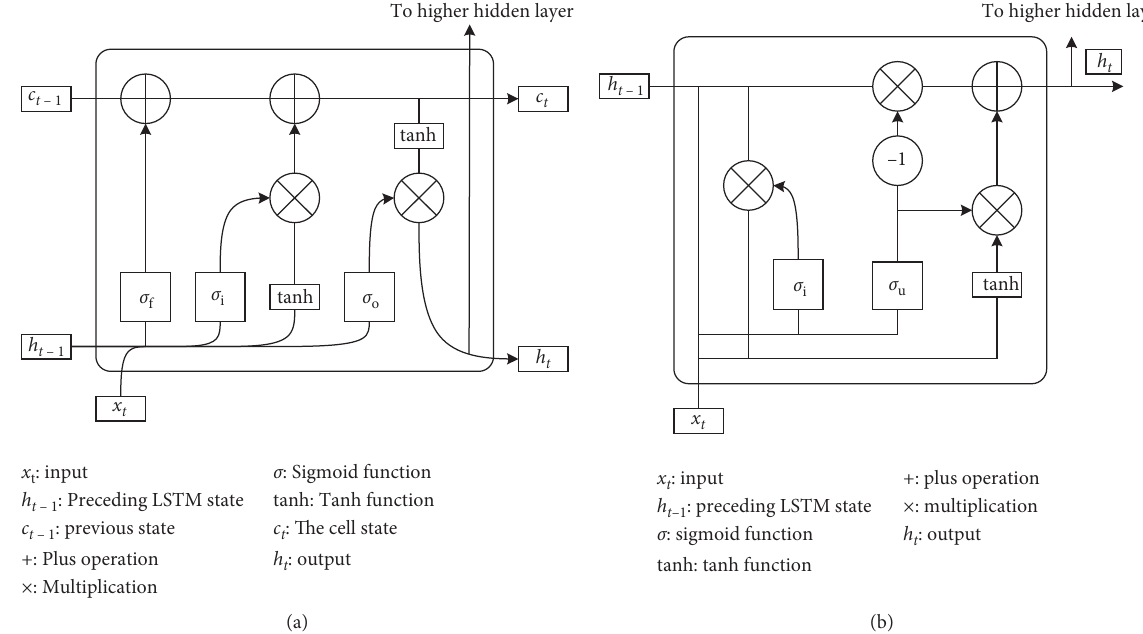
Figure 2: Recurrent neural networks. (a) LSTM-RNN. (b) GRU-RNN.